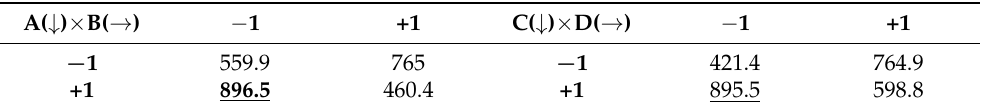
Table 10. Analysis of the interactions AB and CD towards an increase in the energy absorbed to